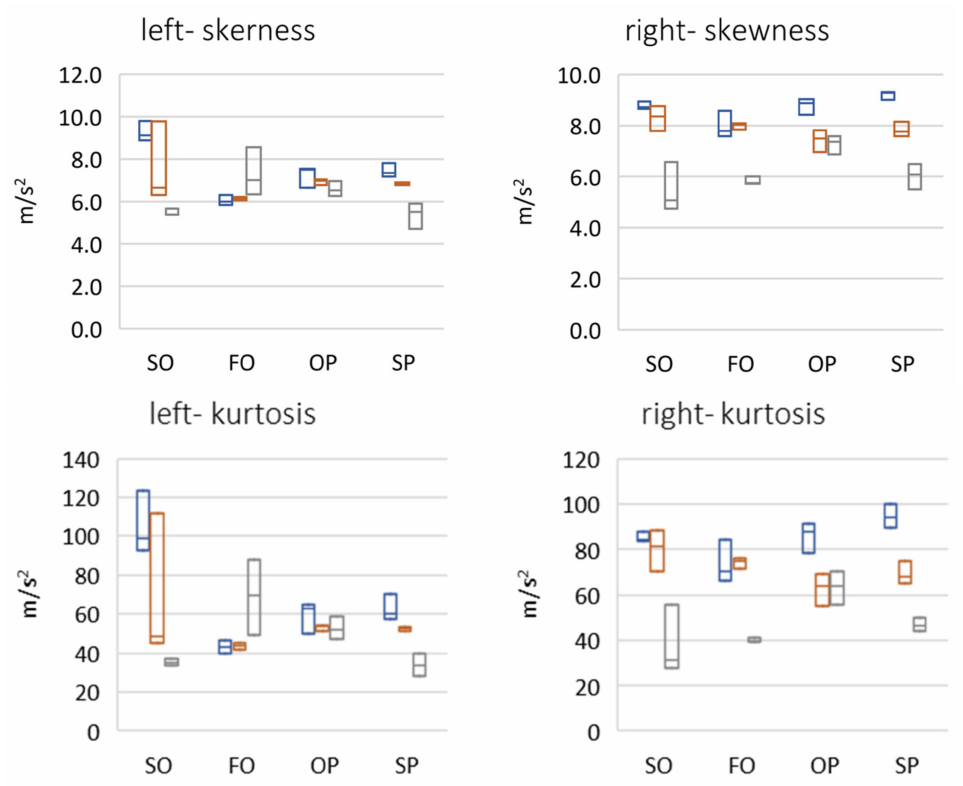
Figure 7. Frequency domain results of vibration signals ( left and right side)—spectral shape pa- rameters (max-median-min). SO (slow opening), FO (fast opening), OP (opening with protruding), SP (slow